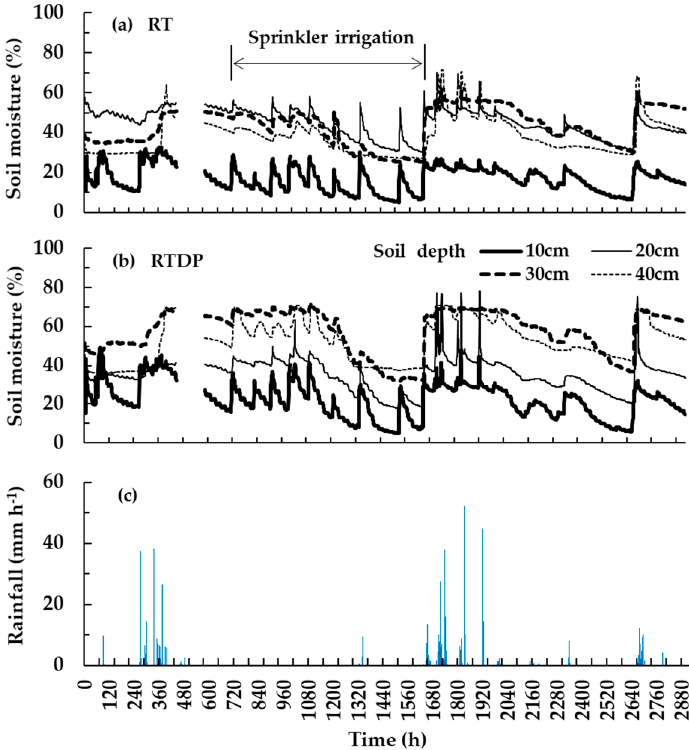
Figure 2. Soil water profiles ( a , b ) and rainfall ( c ) in hour resolution (from 00:00 on 16 June to 23:00 on 15 October) at four soil layers with a 10 cm interval in the range of 1040 cm below the soil surface of drained paddy fields as affected by different tillage systems [rotary tillage (RT) and deep plowing followed by rotary tillage (DPRT)] in 2018 when this study was commenced. Data storage during the period from 16:00 on 4 July (448 h) to 11:00 10 July (586 h) failed due to a temporary power interruption. Hence, it could not provide data in ( a , b ).